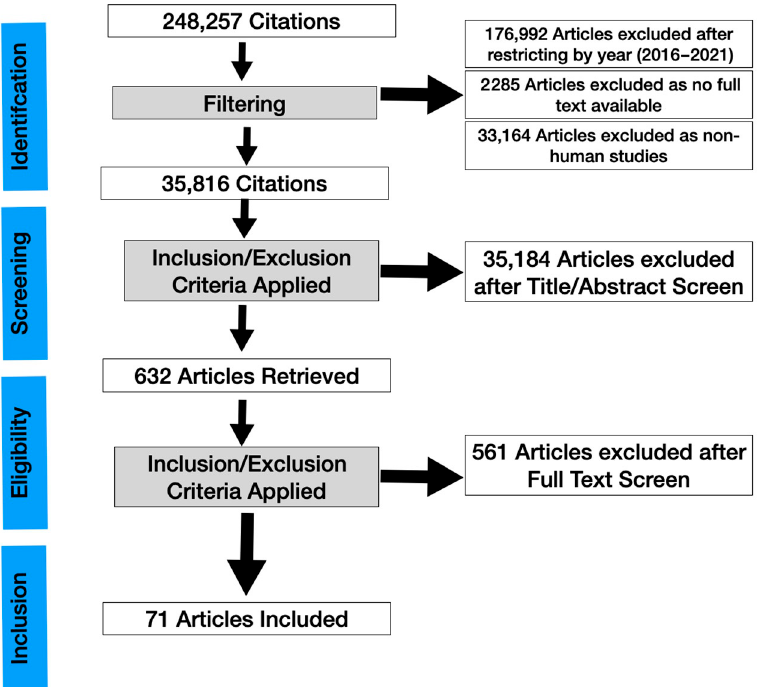
Figure 1. PRISMA flowchart of a systematic review of in vivo confocal microscopy in different types of dry eye and meibomian gland dysfunction.